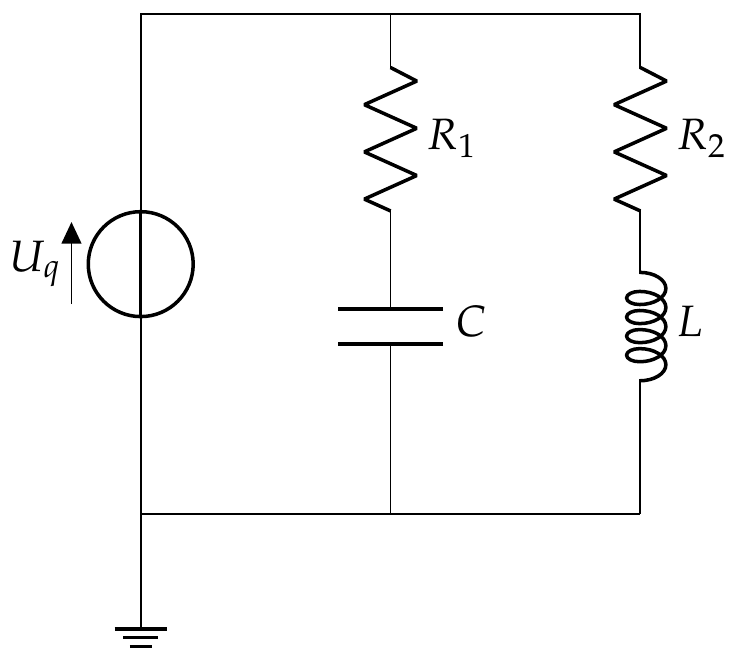
Figure 1. An RLC circuit that is connected to a sine voltage source. The figure is based on the simple circuit model in ([23], p. 37).